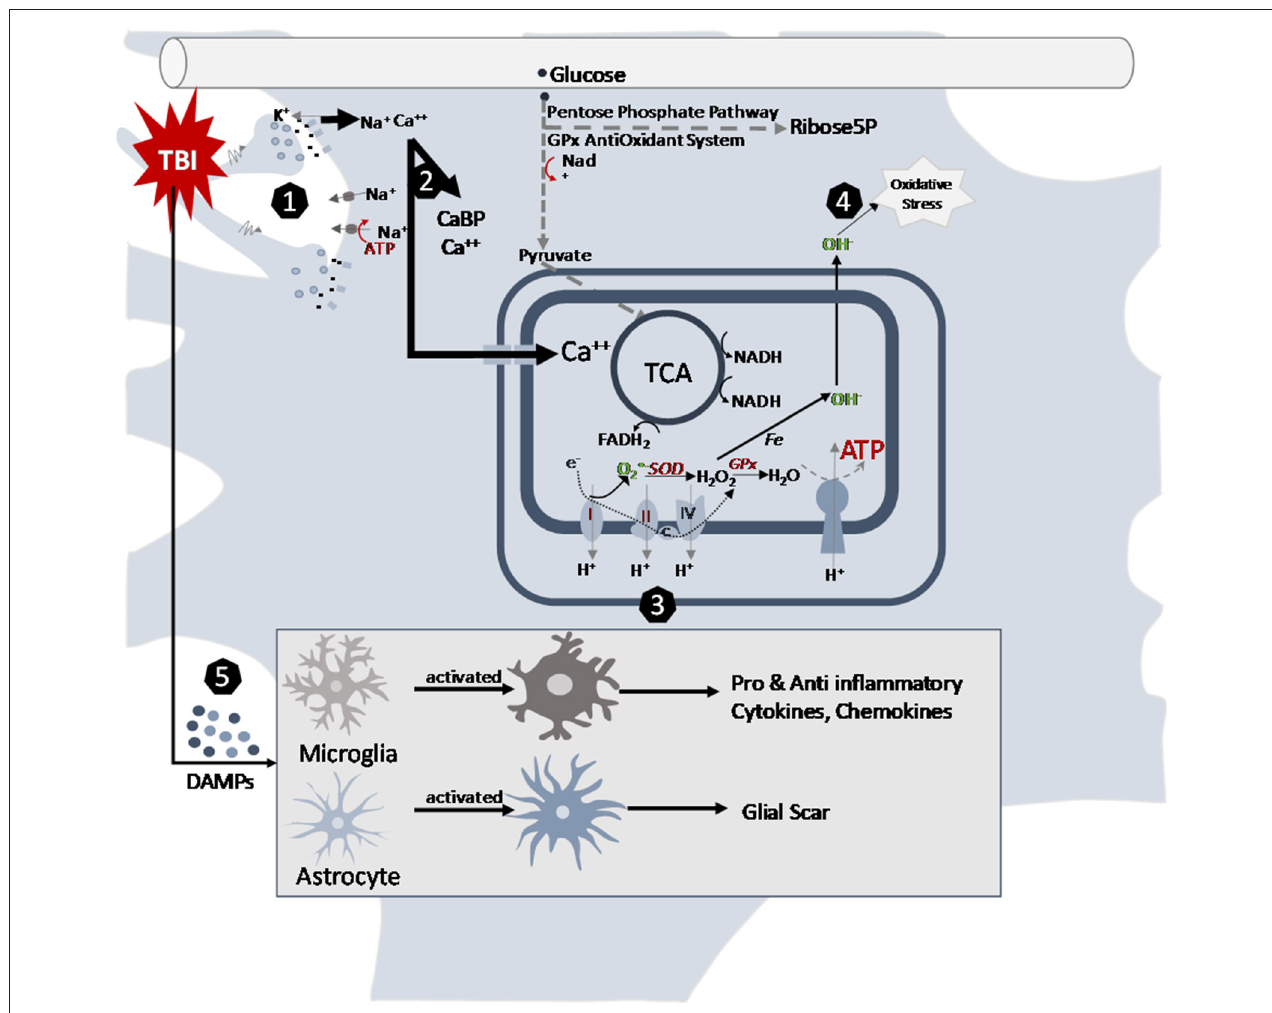
FIGURE 1 | Cellular pathways altered by traumatic brain injury in the juvenile brain. (1) Mechanical movement of the brain tissue causes massive depolarization of neurons. The indiscriminate release of neurotransmitters opens postsynaptic receptors and intermembrane ion concentrations are disrupted as ions flow down their concentration gradients. Na + and Ca ++ accumulates in the cells. Energy demanding ATPase pumps are activated to return ionic homeostasis. (2) Calcium accumulation is managed by calcium binding proteins and sequestration into mitochondria after TBI. (3) Changes in mitochondrial electron transport enzyme activities after TBI contribute to acute decrease ATP production and increase in reactive oxygen species production. The slower maturing anti-oxidant systems contribute to younger age vulnerabilities. (4) Metabolism induced oxygen free radicals form along the electron transport chain. Maturational lower levels of mitochondrial superoxide dismutase (SOD) and antioxidant enzyme glutathione peroxidase (GPx) along with the younger brain’s lessened upregulation after TBI limit their capacity for reactive oxygen species management. This contributes to the oxidative stress of the cells. (5) After TBI, neurons release damage-associated molecular patterns (DAMPs), which induce morphological changes in astrocytes and microglia. In their activated states, microglia release cytokines and chemokines and astrocytes can inhibit microglial signaling and generate glial scarring that then contribute to the inflammatory cascades post